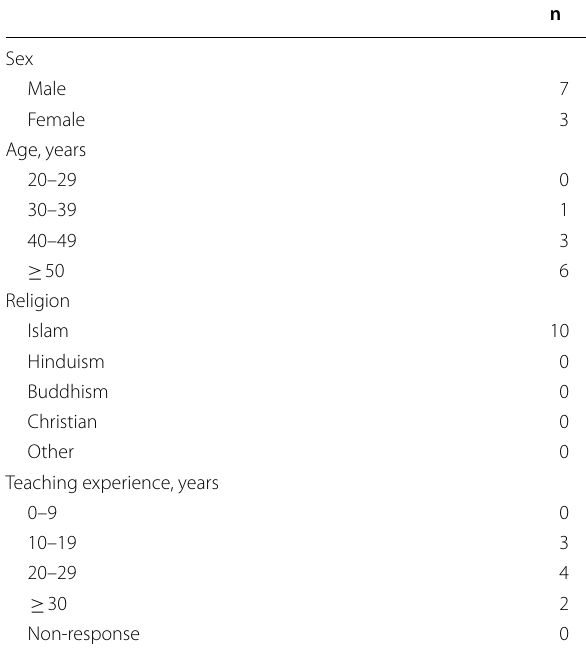
Table 2 Characteristics of the school principals ( N